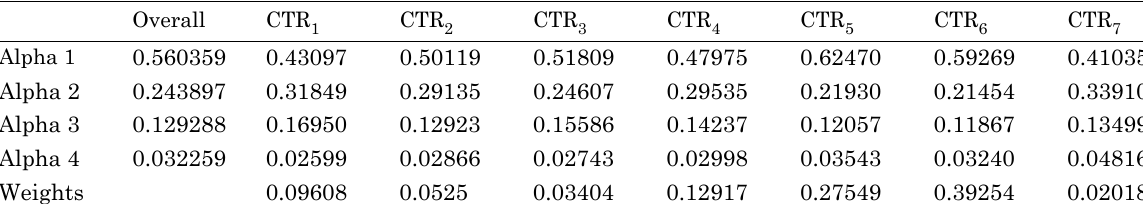
table 3. Impact levels and overall performance per